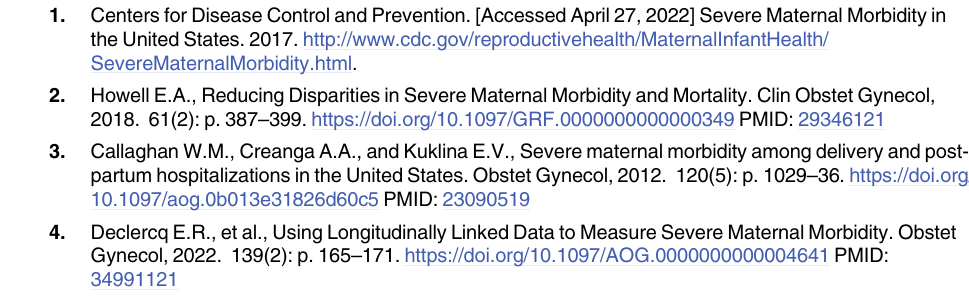
S1 Table. ICD 9 and ICD 10 codes used to identify severe maternal